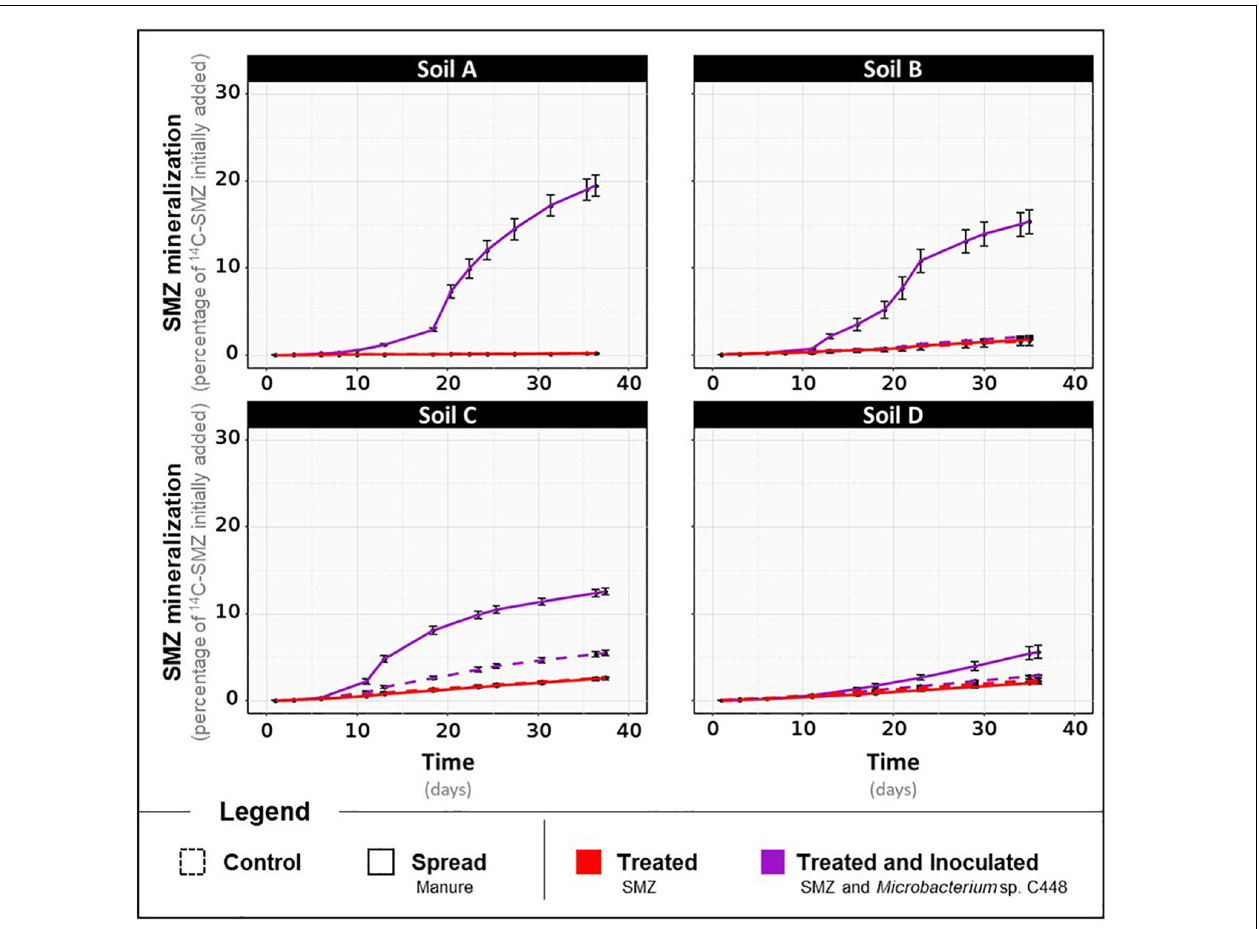
FIGURE 2 | Kinetics of 14 C-SMZ mineralization throughout the incubation for the four different types of soils, A, B, C, and D, treated with SMZ, amended or not with manure, and inoculated or not with Microbacterium sp. C448. Results are expressed in percentage of initially added 14